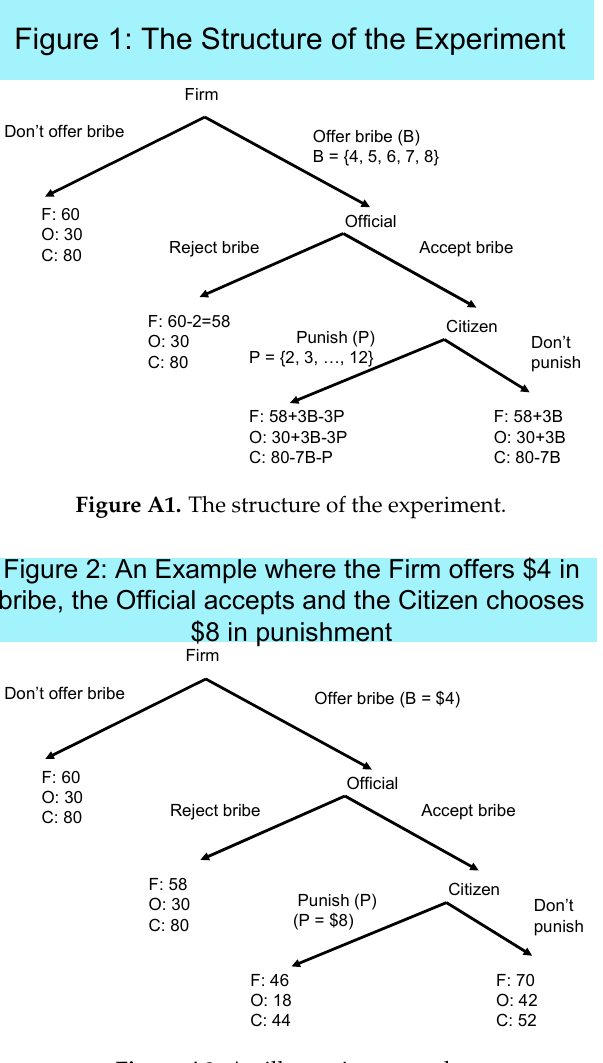
Figure A2. An illustrative example.